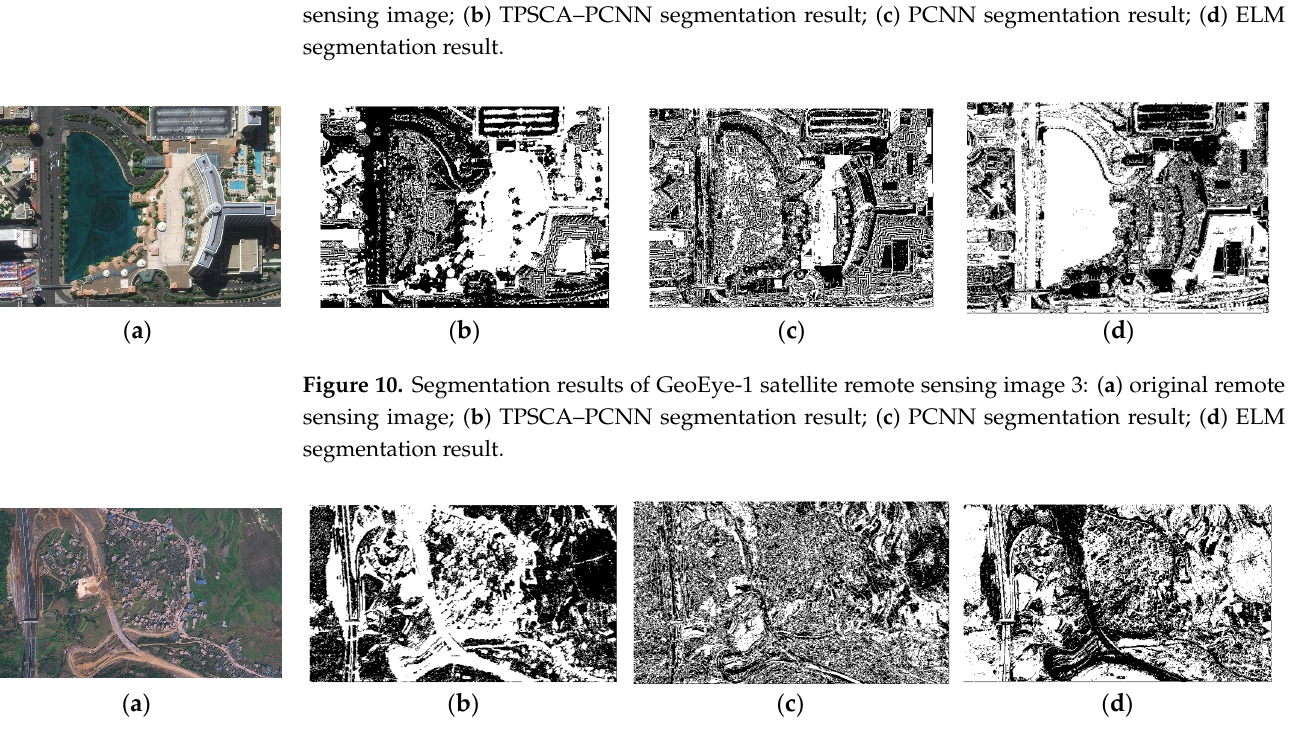
Figure 11. Segmentation results of GeoEye-1 satellite remote sensing image 4: ( a ) original remote sensing image; ( b ) TPSCA–PCNN segmentation result; ( c ) PCNN segmentation result; ( d ) ELM segmentation result.